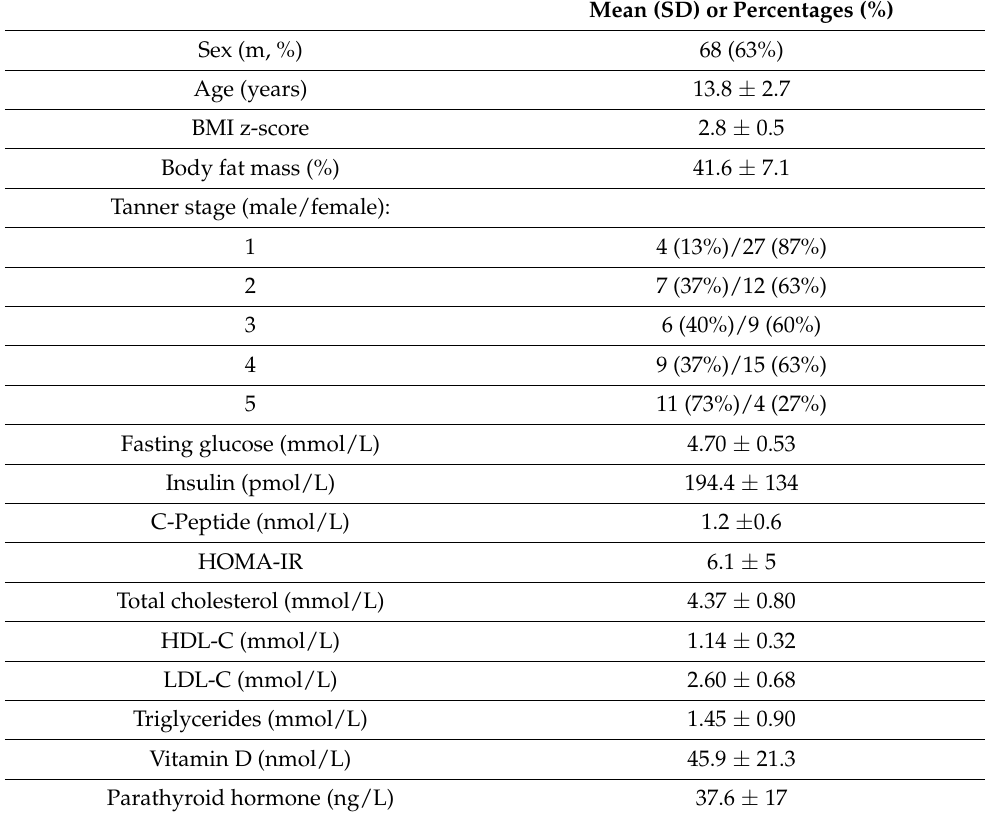
Table 1. Characteristics of the study